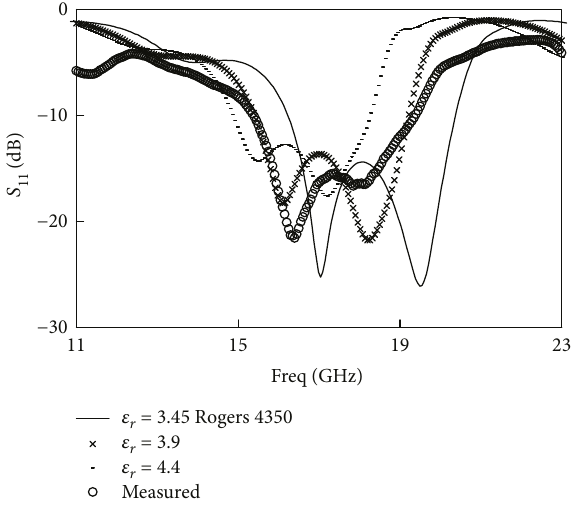
Figure 8: Computed S values for the proposed metamaterial 11 antennas with di ff erent relative